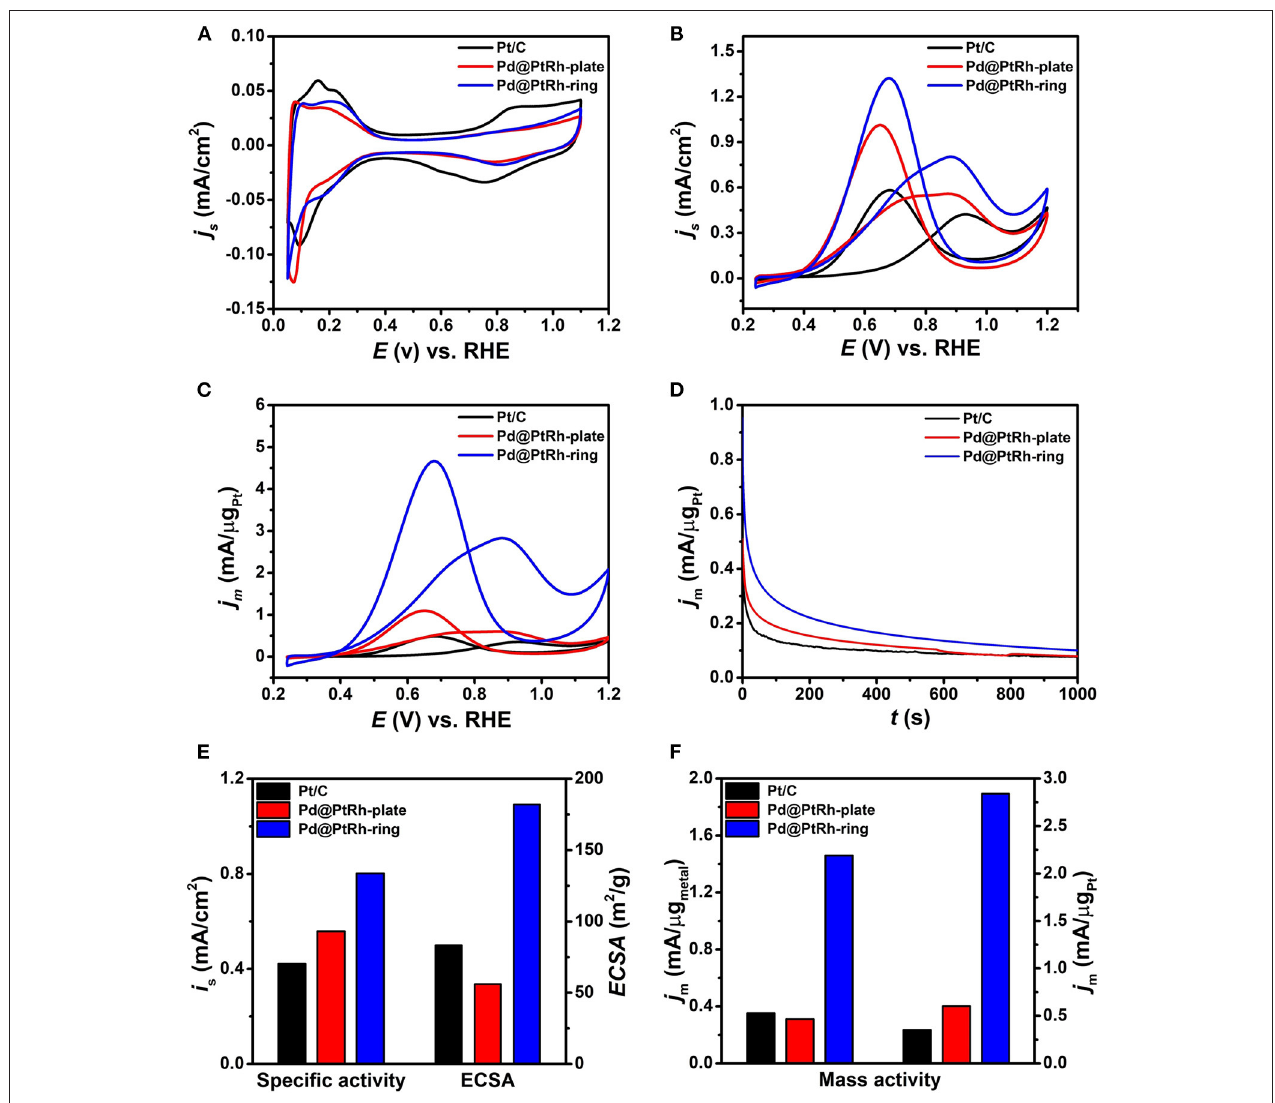
FIGURE 4 | Electrochemical characterization of carbon supported Pd@PtRh nanorings, Pd@PtRh nanoplates, and Pt/C catalysts: (A) CV curves in 0.1M HClO 4 solution at a scan rate of 50 mV/s; (B,C) CV curves normalized with ECSAs and Pt mass, respectively, in a mixed solution containing 0.5M H 2 SO 4 and 0.5M EtOH